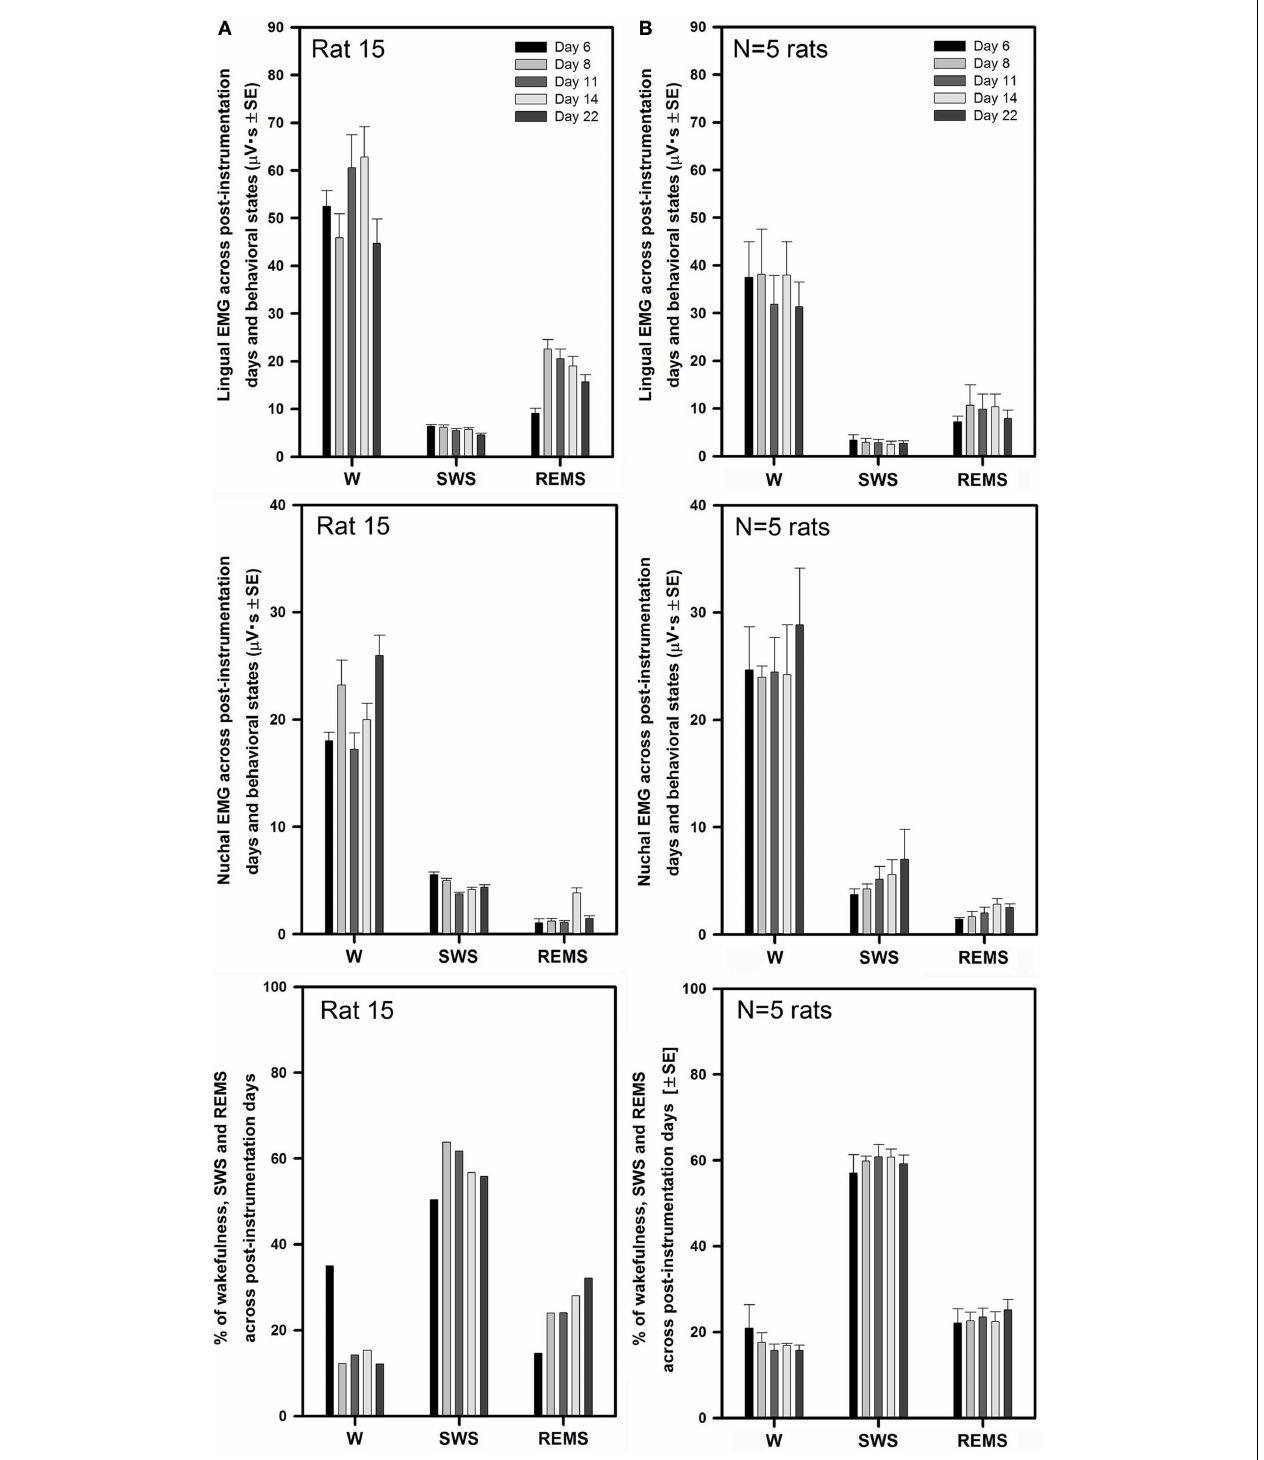
levels of lingual and nuchal EMG, and the mean percentage amounts of wakefulness, SWS, and REMS in the five rats with compromised upper airway studied on the same 5days after instrumentation.Within this data set, the level of nuchal EMG during REMS was higher on day 14 when compared to day 6 ( p = 0.04); other than that, no significant effects of the recording day were